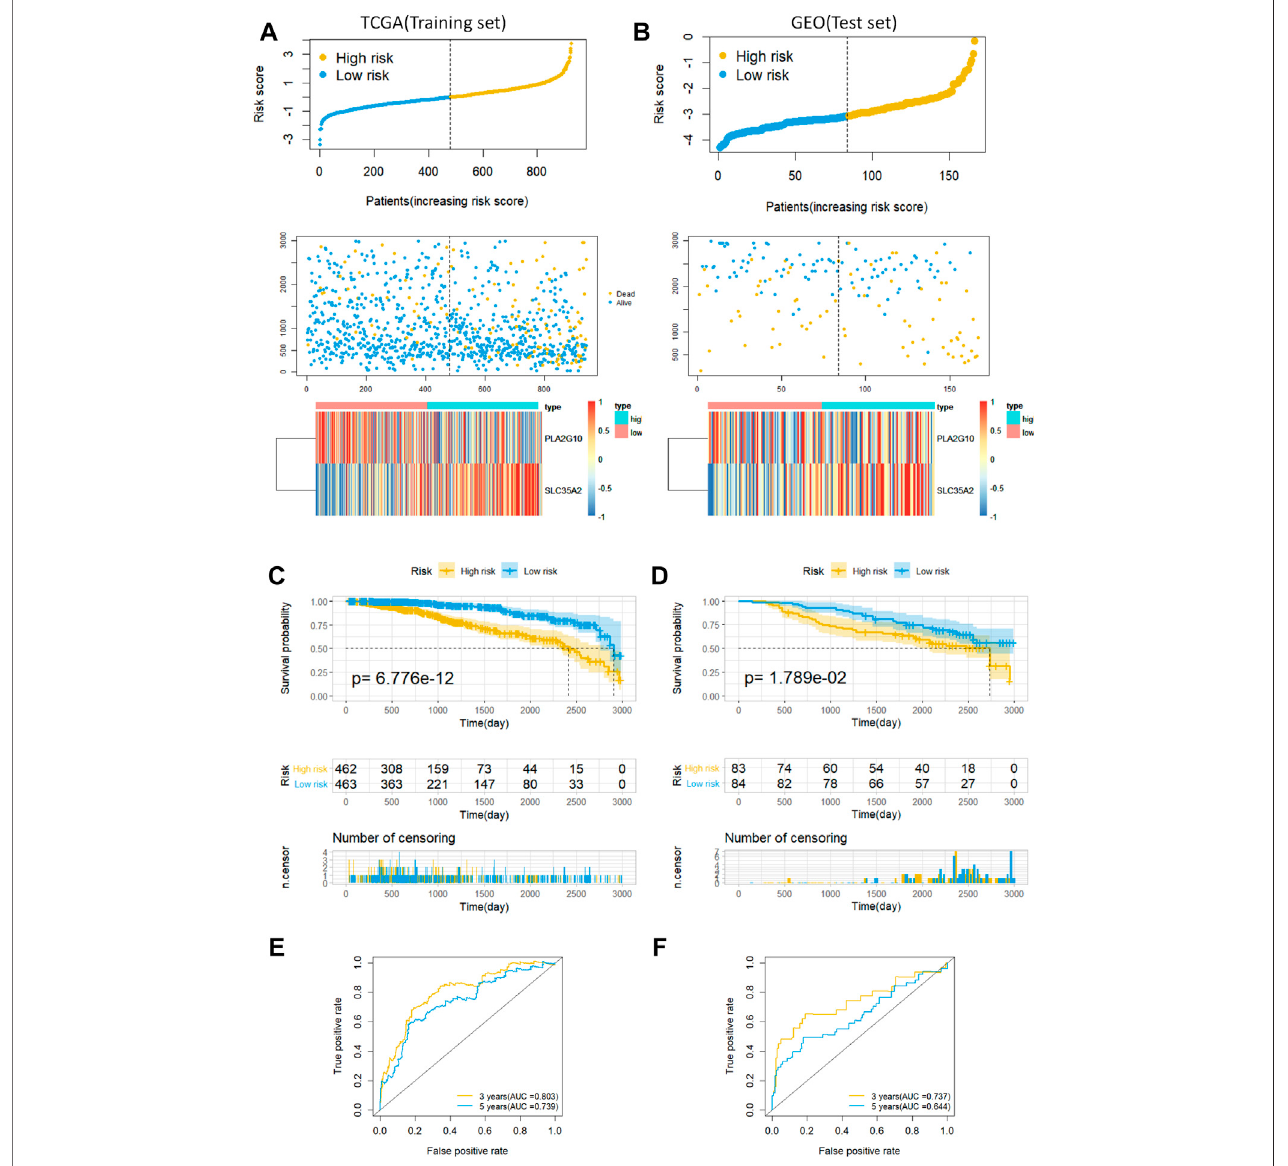
FIGURE 3 | Predictive characteristics of the model MAS in the training and validation sets. (A,B) Distribution of risk scores, survival status and heat maps of gene expression for patients in the high- and low-risk groups. (C,D) Kaplan-Meier analysis of OS in breast cancer patients based on risk scores. (E,F) ROC curve analysis to validate the performance of the MAS in predicting survival at 3 and 5 years for breast